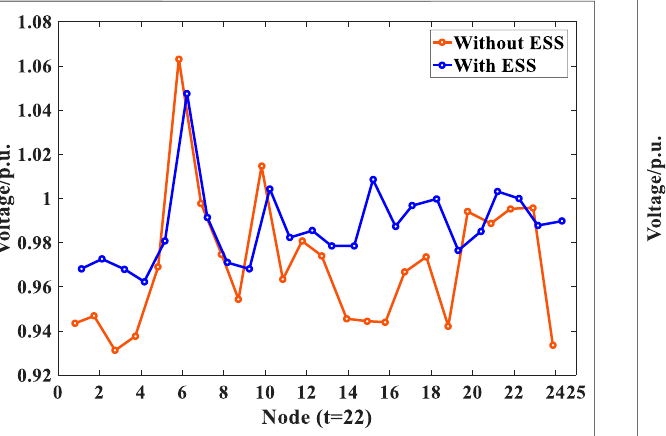
FIGURE 9 | The voltage pro fi le (p.u.) of the network without or with the ESS deployment at off-peak time (time step 22).